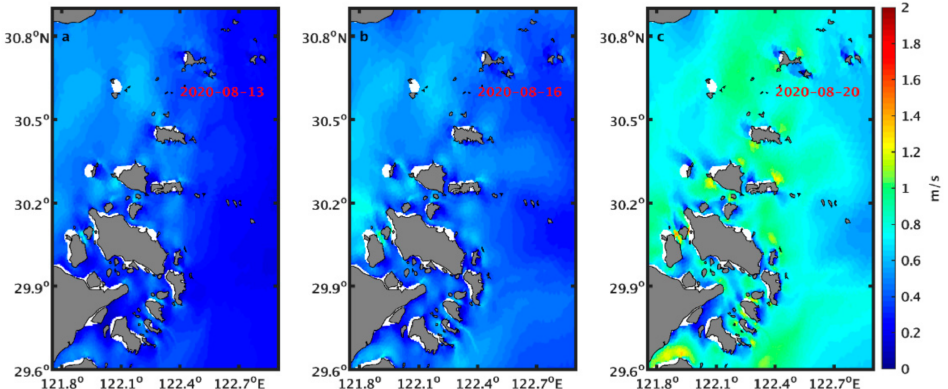
Figure 9. Temporally averaged surface velocities from the simulated results corresponding to the daily averaged SSC during neap ( a ), middle ( b ), and spring tides ( c